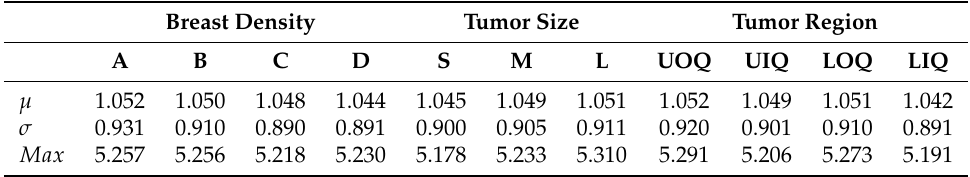
Table 10. Individual evaluation of the clinical features (breast density, tumor size, and tumor region) with respect to the adaptive weight RF in scope of the average OF.